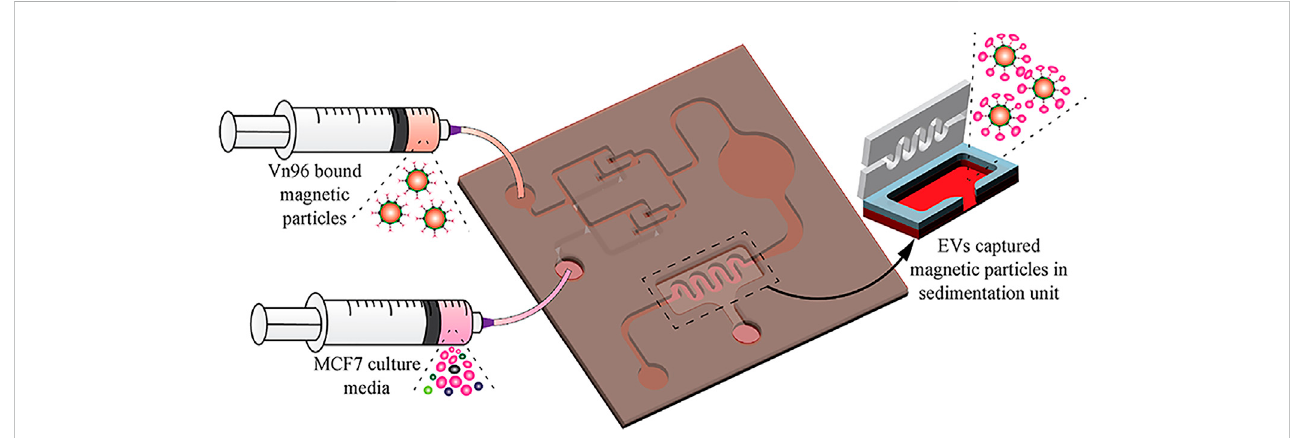
FIGURE 6 Scheme of the EV-isolation from MCF7 CCM. Vn96-bound magnetic particles are injected into the liquid biopsy chip simultaneously with MCF7 CCM at the same fl ow rate for EVs isolation. EVs are captured by the magnetic particles in the sedimentation unit. Reproduced with permission from (Bathini et al., 2021).